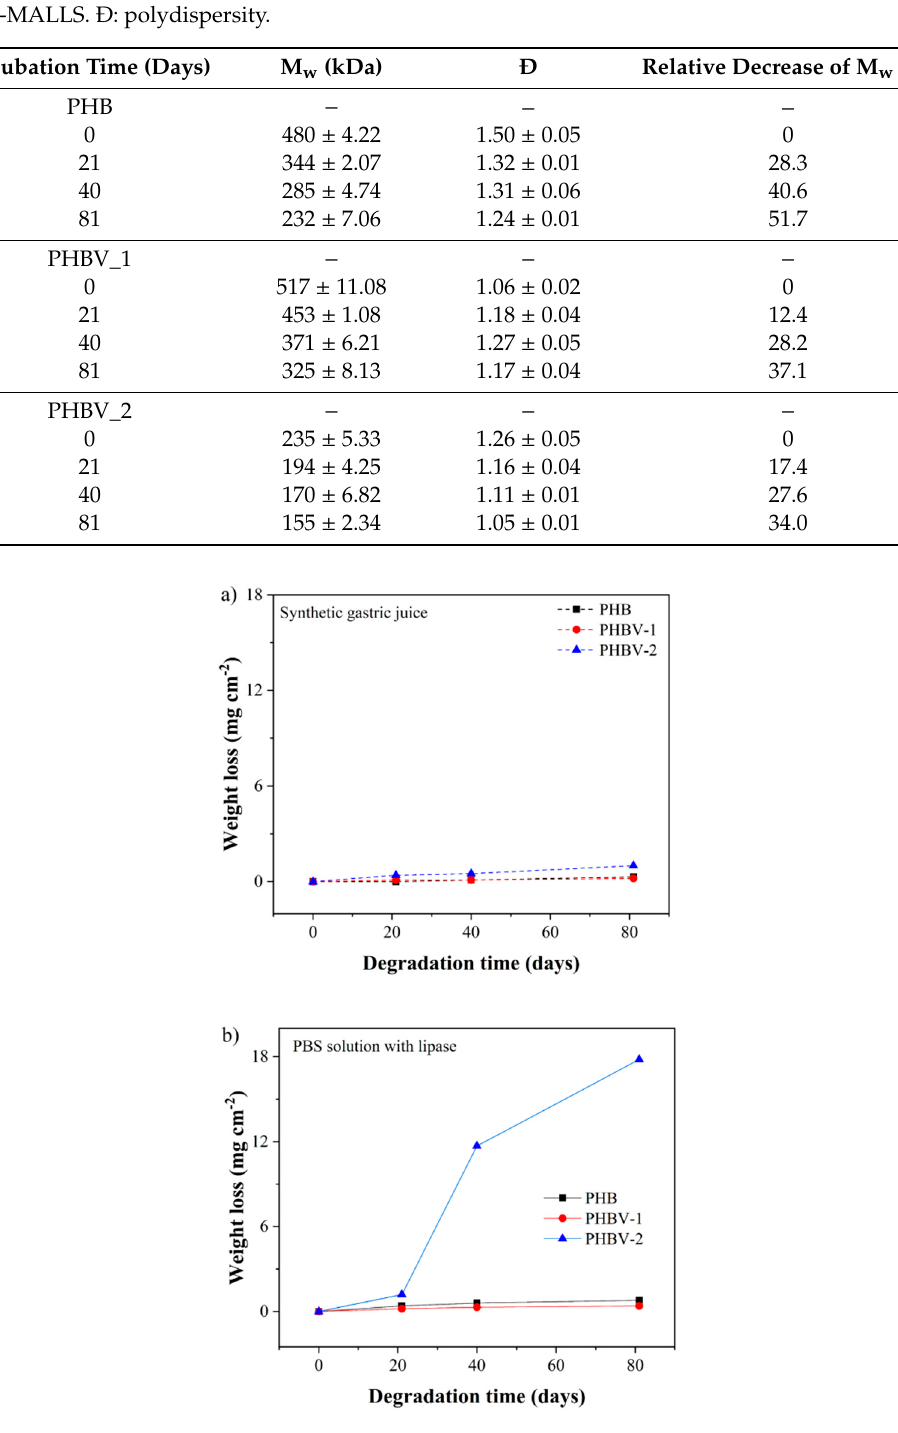
Table 6. Molecular weight changes in the PHA scaffolds in vitro at 37 °C in a phosphate buffer saline solution with lipase determined by SEC-MALLS.